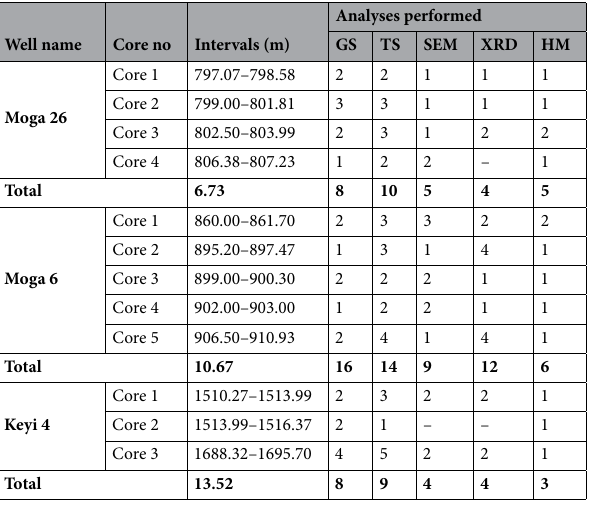
Table 1. Compendium of analyzed core samples from Moga 26, Moga 6 and Keyi 4 wells in the Fula Sub- basin Muglad Basin, Sudan. Abbreviations for Analyses performed: GS: Grain-size Analysis; TS: Thin Section Analysis; SEM:Scanning Electron Microscope Analysis; XRD: X-Ray Diffraction Analysis of the < 2 and HM: Heavy Minerals